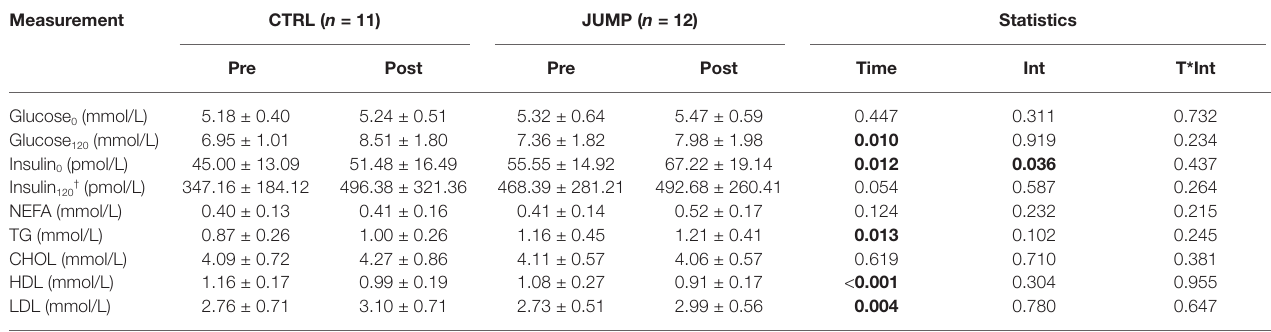
FIGURE 1 | The effects of 60 days of HDT bed rest on metabolic variables measured on BDC-5 (pre) and HDT59 (post). Data are presented as mean ± standard error of mean (SEM). The glucose and insulin response curve to the OGTT are displayed in (A) and (B) , respectively. The 120 min area under the curve totals for glucose are shown in (C) and for insulin in (D) . The pre to post changes in OGTT derived indexes of Matsuda, liver IS, muscle IS, and adipose IR are presented in (E–H) . Abbreviations: CTRL, control group; JUMP, jumping countermeasure group; AUCG, area under the curve for glucose for 120 min; AUCI, area under the curve for insulin for 120 min; IS, insulin sensitivity; IR, insulin resistance; Time, main effect of time; Int, main effect of intervention; T * Int, time * intervention interaction effect. * p ≤ 0.05 and ** p ≤ 0.010. TABLE 2 | The effects of 60 days HDT bed rest on metabolic